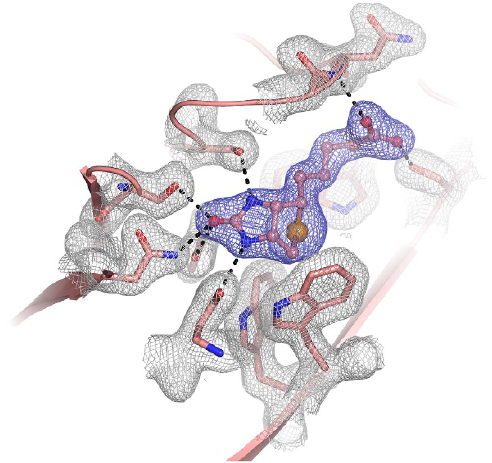
Figure 2 | Electron-density map of the selenobiotin-binding site. Final 2 Fo - Fc electron-density map of selenobiotin-binding pocket contoured at the 1 s level. Selenobiotin is shown in balls and sticks model and its electron-density coloured in blue. The locations of active site residues are shown and their electron-density is coloured in grey.